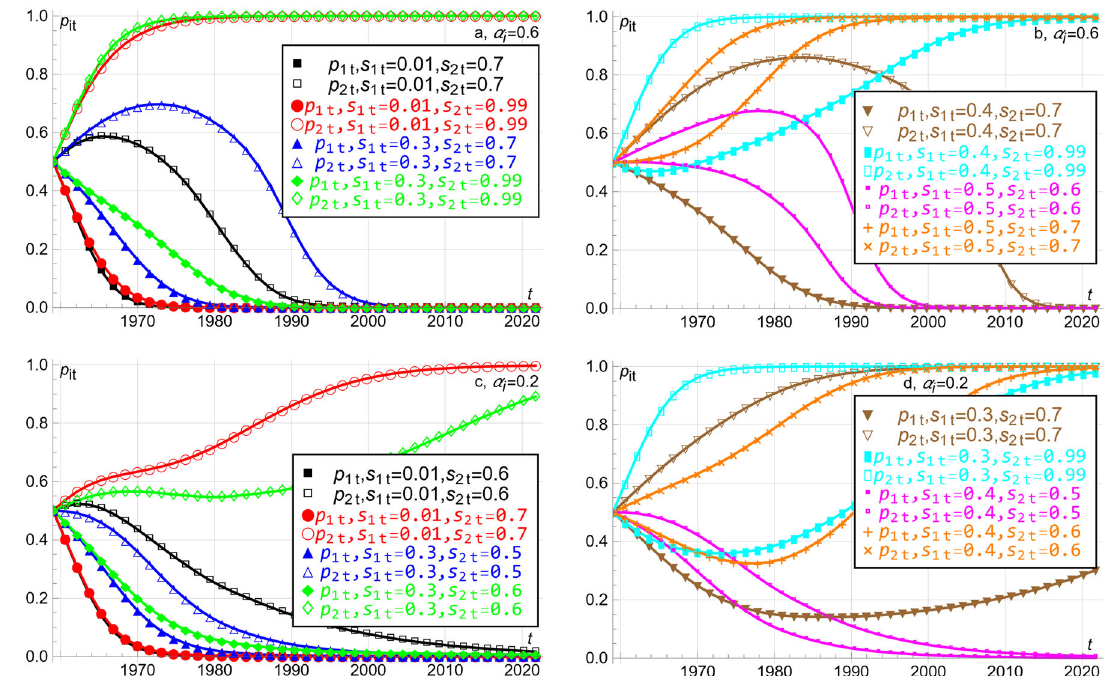
Fig. 5 The volume fractions p 1 t and p 2 t of the two kinds of players ’ transactions in currency g at time t 1959 – 2021 with different support s 1 t ≠ s 2 t when ¼ k ¼ 0 : 5, μ ¼ 0, and 0 : 01 (cid:4) s q it ¼ p it i i 0